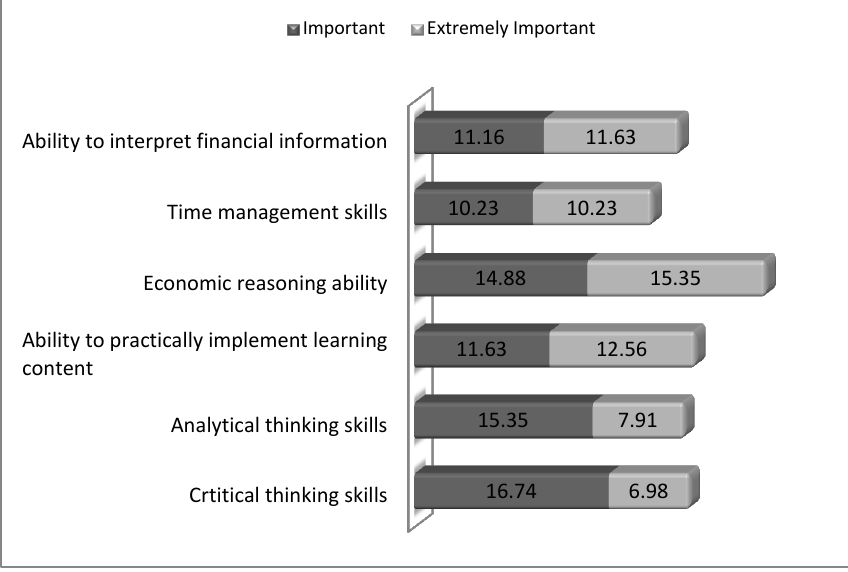
FIGURE 3: Skills not acquired in the NSC, but required in B.Com (Finance) (n =